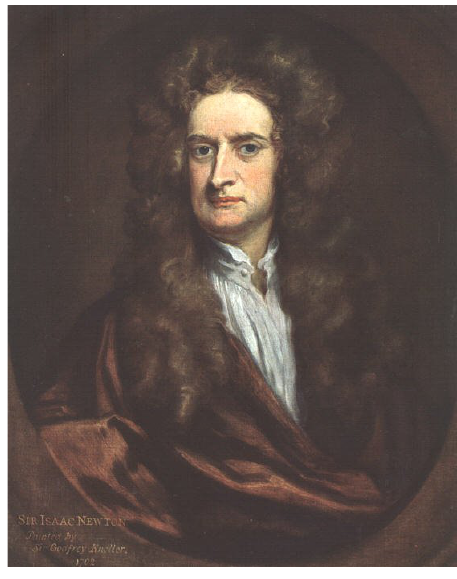
Figure 4: One of Kneller’s portaits of Newton. Second Law The alteration of motion is proportional to the motive force impressed; and is made in the direction of the right line in which that force is